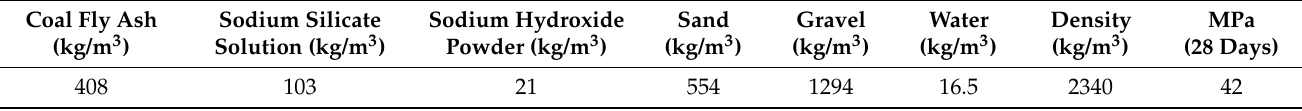
Table 6. Reference geopolymer mix design